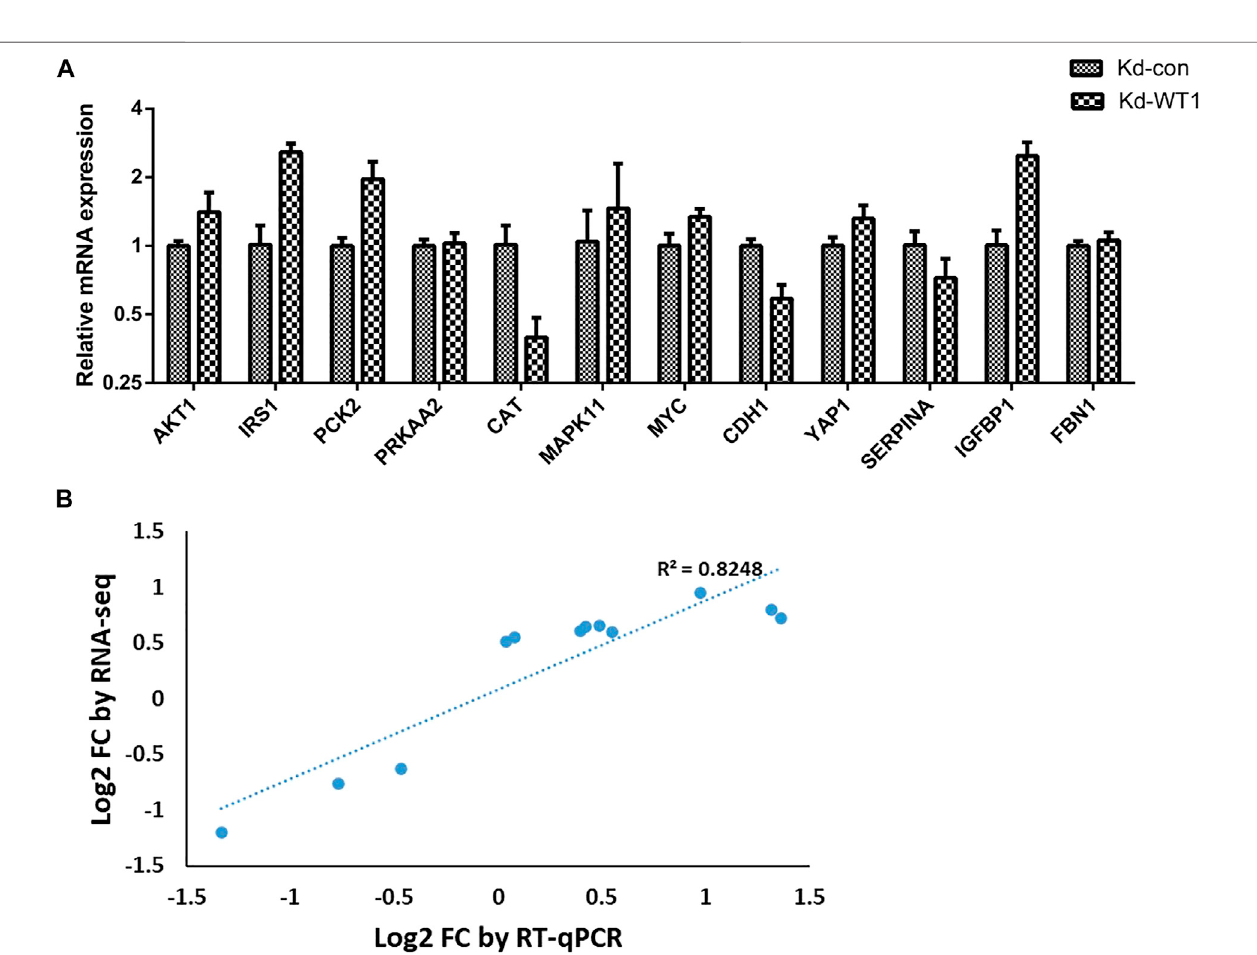
FIGURE 4 | RT-qPCR veri fi cation of RNA sequencing data. (A) Differential expression levels of 12 screened mRNA detected using RT-qPCR. (B) Scatter plots verifying the consistency of the two platforms. GAPDH used as control. Kd: knockdown; con: control; RT-qPCR: reverse transcription quantitative polymerase chain